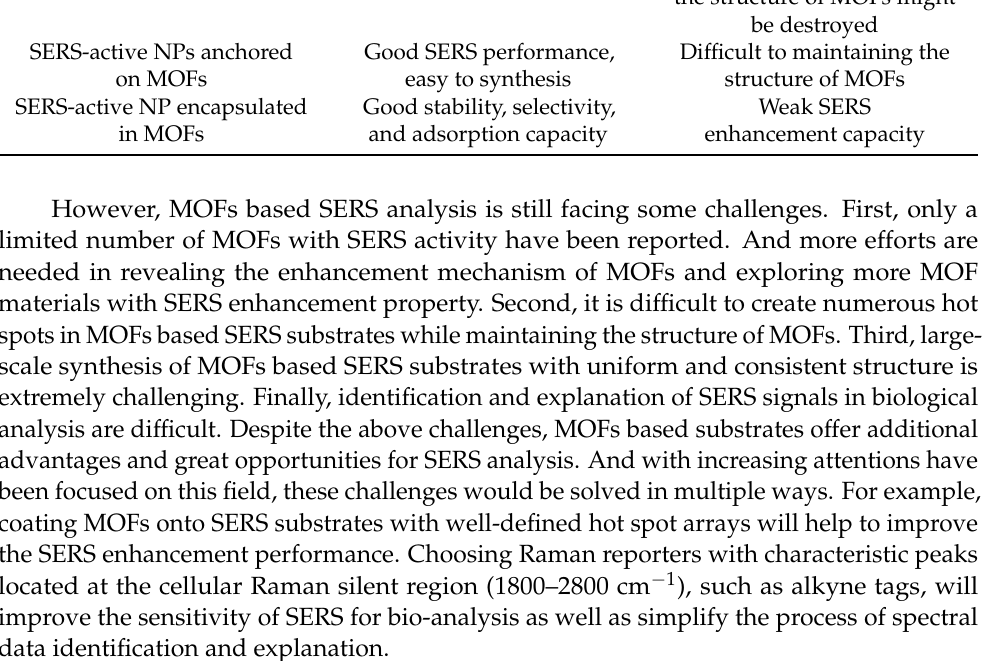
Table 4. Summary of the advantages and disadvantages of MOFs based SERS substrates. Type Advantages Disadvantages Diverse structure, molecular MOFs selectivity, good for Numbers are limited mechanism research The morphology, quantity, and location of NPs inside SERS-active NPs embedded Easy to synthesis MOFs are hard to control, in MOFs the structure of MOFs might be